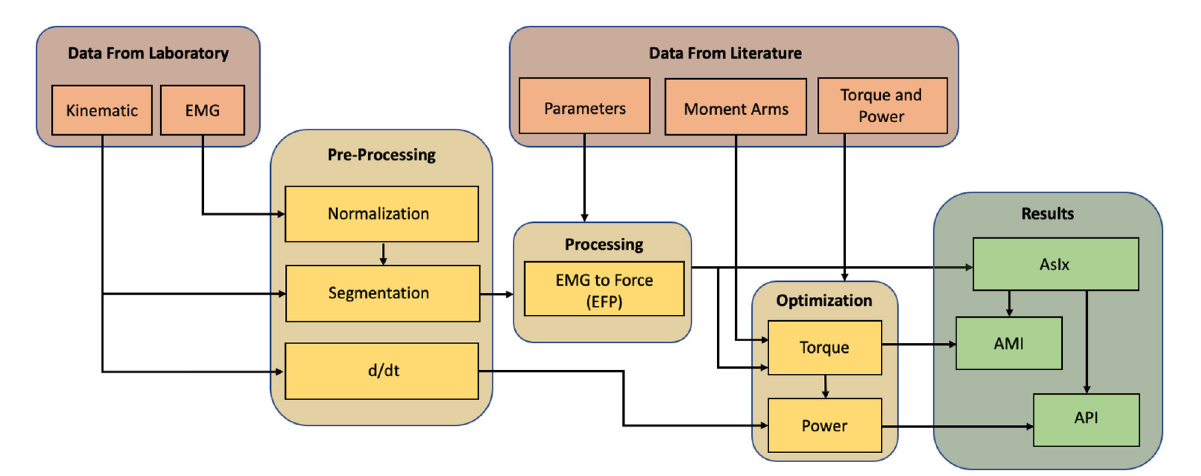
FIGURE1 Methodology workflow. Data recorded in the laboratory is pre-preprocessed and integrated with data taken from literature to compute the EMG to force processing. The output is compared with the literature and optimized to approach the same trends. After the optimization, the assistive indexes can be calculated.